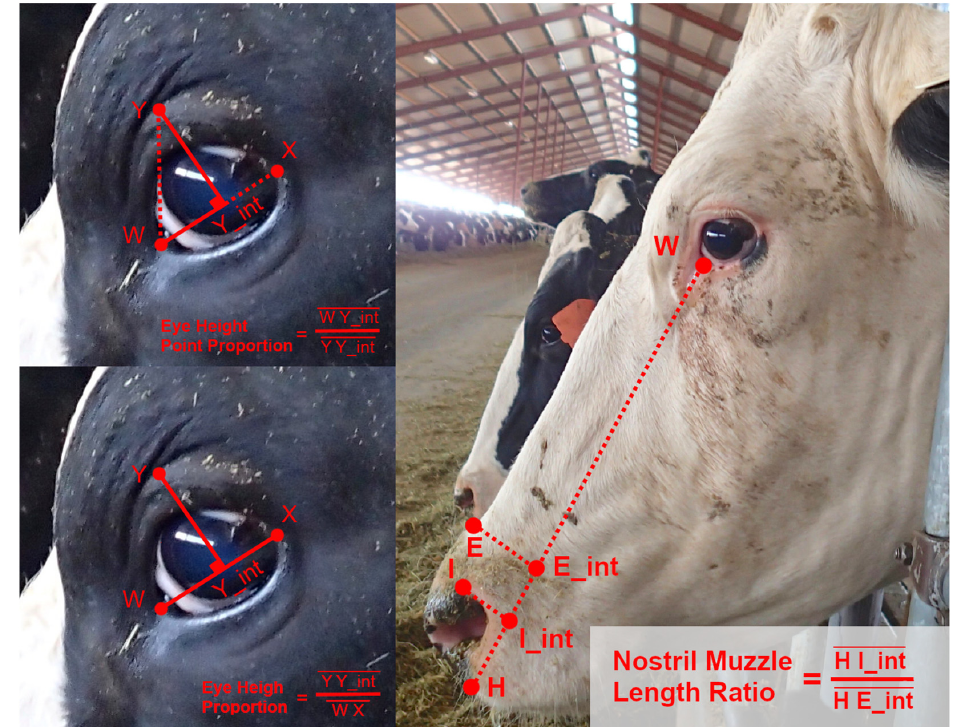
Figure 1. Examples of Projective Biometrics. Eye Height Point Proportion ( upper left ) is an example of an orthogonal projection that is geometrically equivalent to an angle measure via a trigonometric transform. Eye Height Proportion ( bottom left ) provides a more geometrically intuitive definition of eye height using only a single locally defined normalization term. Nostril-Muzzle Length Ratio ( right ) is an example of how projections onto a reference line can provide more anatomically intui- tive distance measures.